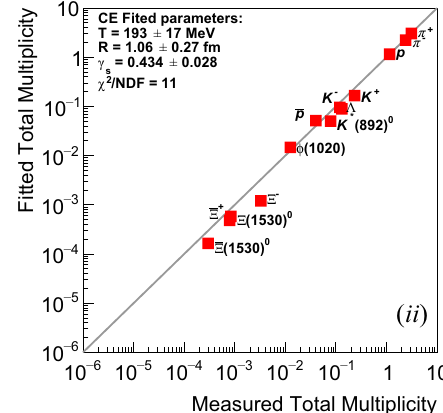
Fig. 10 Rapidity spectra of (cid:2)( 1530 ) 0 ( left ), (cid:2)( 1530 ) 0 ( middle ) and (cid:2)( 1530 ) 0 /(cid:2)( 1530 ) 0 ratio ( right ) measured in inelastic p+p interactions at 158 GeV / c . Shaded bands show systematic uncertainties. U r qmd 3.4 [14,15] and Epos 1.99 [13] predictions are shown as magenta and blue points, respectively